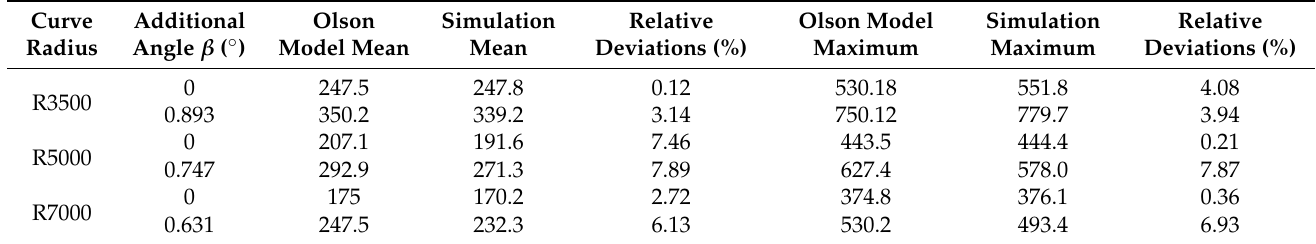
Table 9. The impact forces of final simulation results at 300 km/h on the six